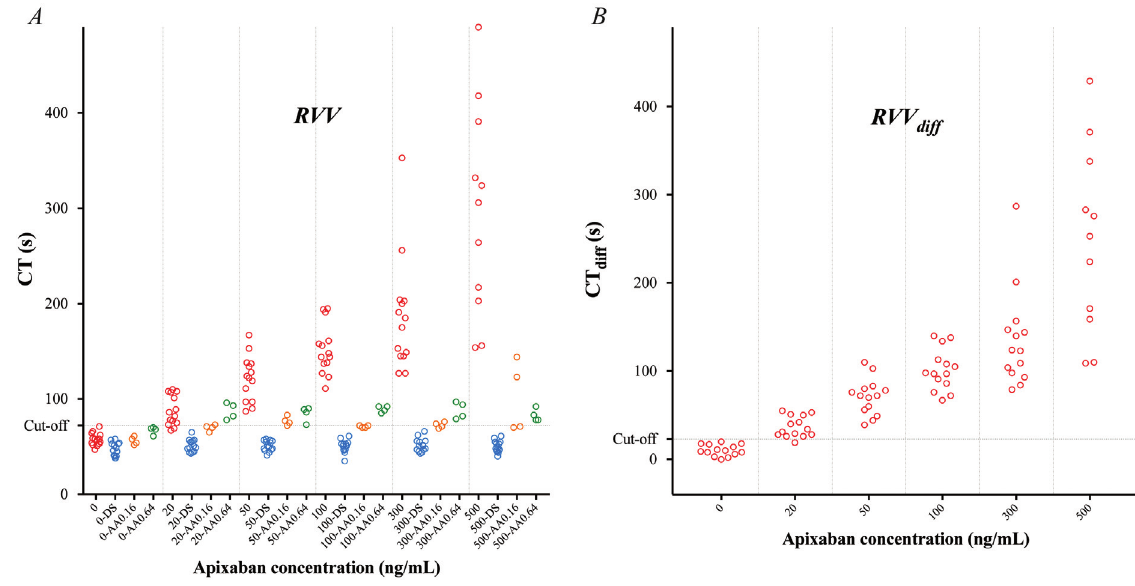
Fig. 3 Rotational thromboelastometry (ROTEM) analyses using the Russell viper venom (RVV) trigger – variables clotting time (CT) ( A ) and CT diff ( B ; the difference in CTwithout vs. with DOAC-Stop [DS]) – performed on blood samples from 14 healthy controls incubated with apixaban at estimated plasma concentrations0,20,50,100,300,and500ng/mL(red).SampleswereanalyzedintheabsenceorpresenceofDOAC-Stop(DS;blue)andandexanetalfa(AA; performedinsamplesfrom 4 outof14donors) – thelatter intwodifferent concentrations(0.16[orange] and0.64[green] mg/mL).Cutoff line represents optimal receiver operating characteristics (ROCs) for discriminating between samples with apixaban concentration above or below 20ng/mL.